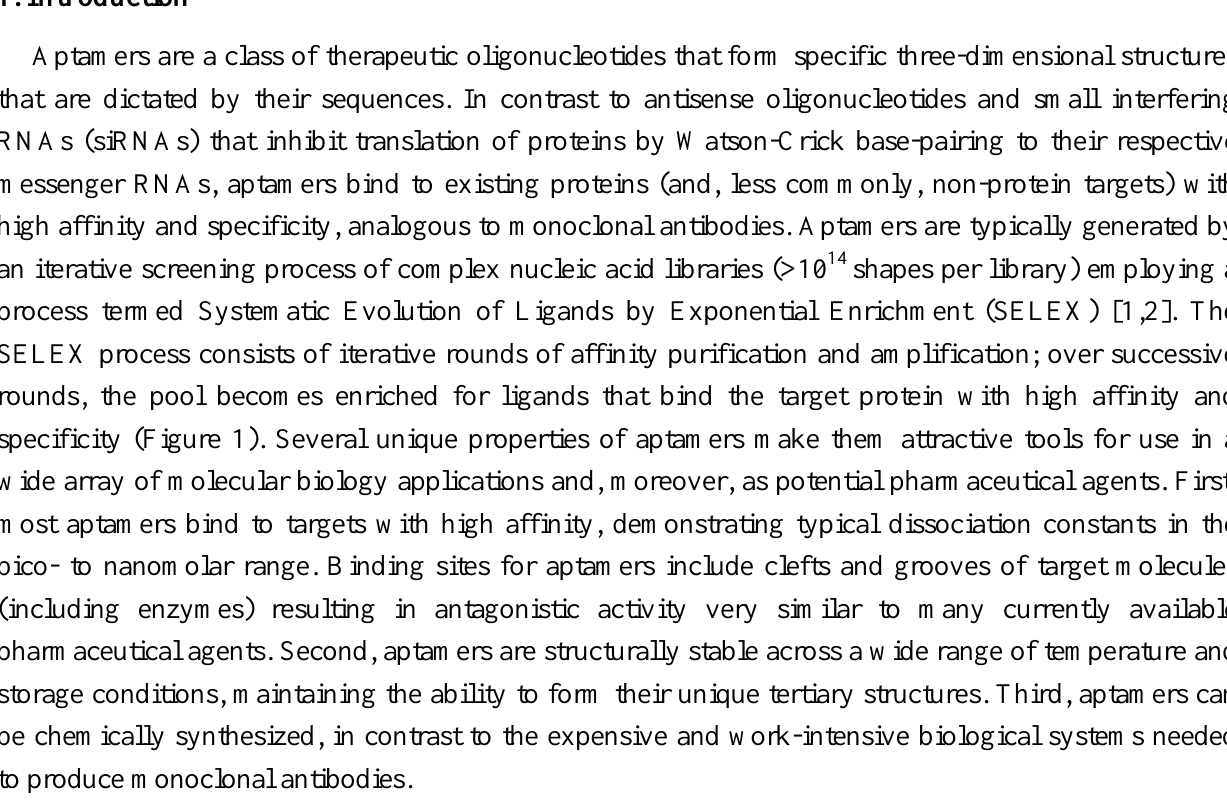
Figure 1. Schematic of Systematic Evolution of Ligands by Exponential Enrichment